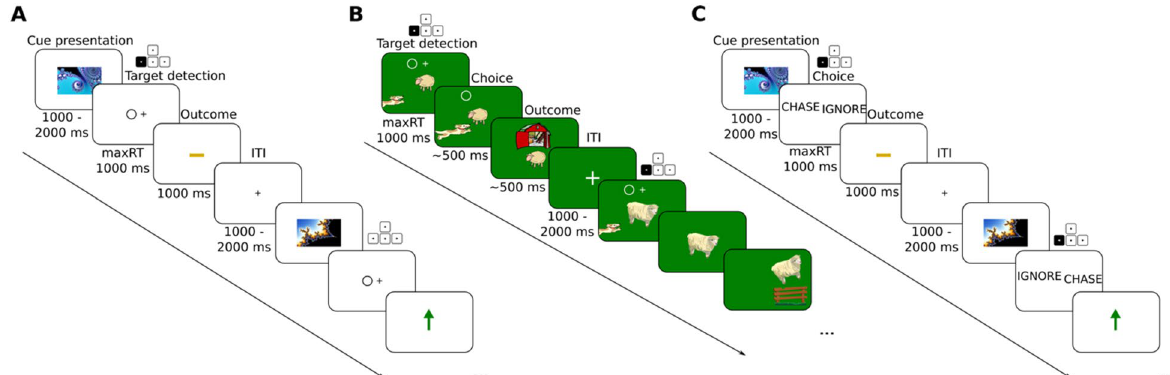
Figure 4. Task design in experiments 3, 4 and 5. ( A ) Task design for M g− . Two example trials are shown. The highlighted buttons on keypads show what correct responses would be. The first trial shows a stimulus in the ‘go to avoid losing’ condition. The subject correctly presses and neutral feedback is shown in the outcome phase. The second trial shows a stimulus in the ‘no go to win’ condition. The subject correctly chooses to not press and positive feedback is shown in the outcome phase. ( B ) Task design for M g+ . Two example trials are shown. The highlighted buttons on keypads show what correct responses would be. The first trial shows a stimulus in the ‘go to win’ condition. The subject correctly presses and positive feedback is shown in the outcome phase. The second trial shows a stimulus in the ‘go to avoid losing’ condition. The subject correctly presses, but due to the probabilistic nature of the feedback, negative feedback is shown in the outcome phase. ( C ) Task design for SS g− . Two example trials are shown. The highlighted buttons on keypads show what correct responses would be. The first trial shows a stimulus in the ‘go to avoid losing’ condition. The subject correctly chooses ‘chase’ and neutral feedback is shown in the outcome phase. The second trial shows a stimulus in the ‘no go to win condition. The subject correctly chooses ‘ignore’, and positive feedback is shown in the outcome phase.